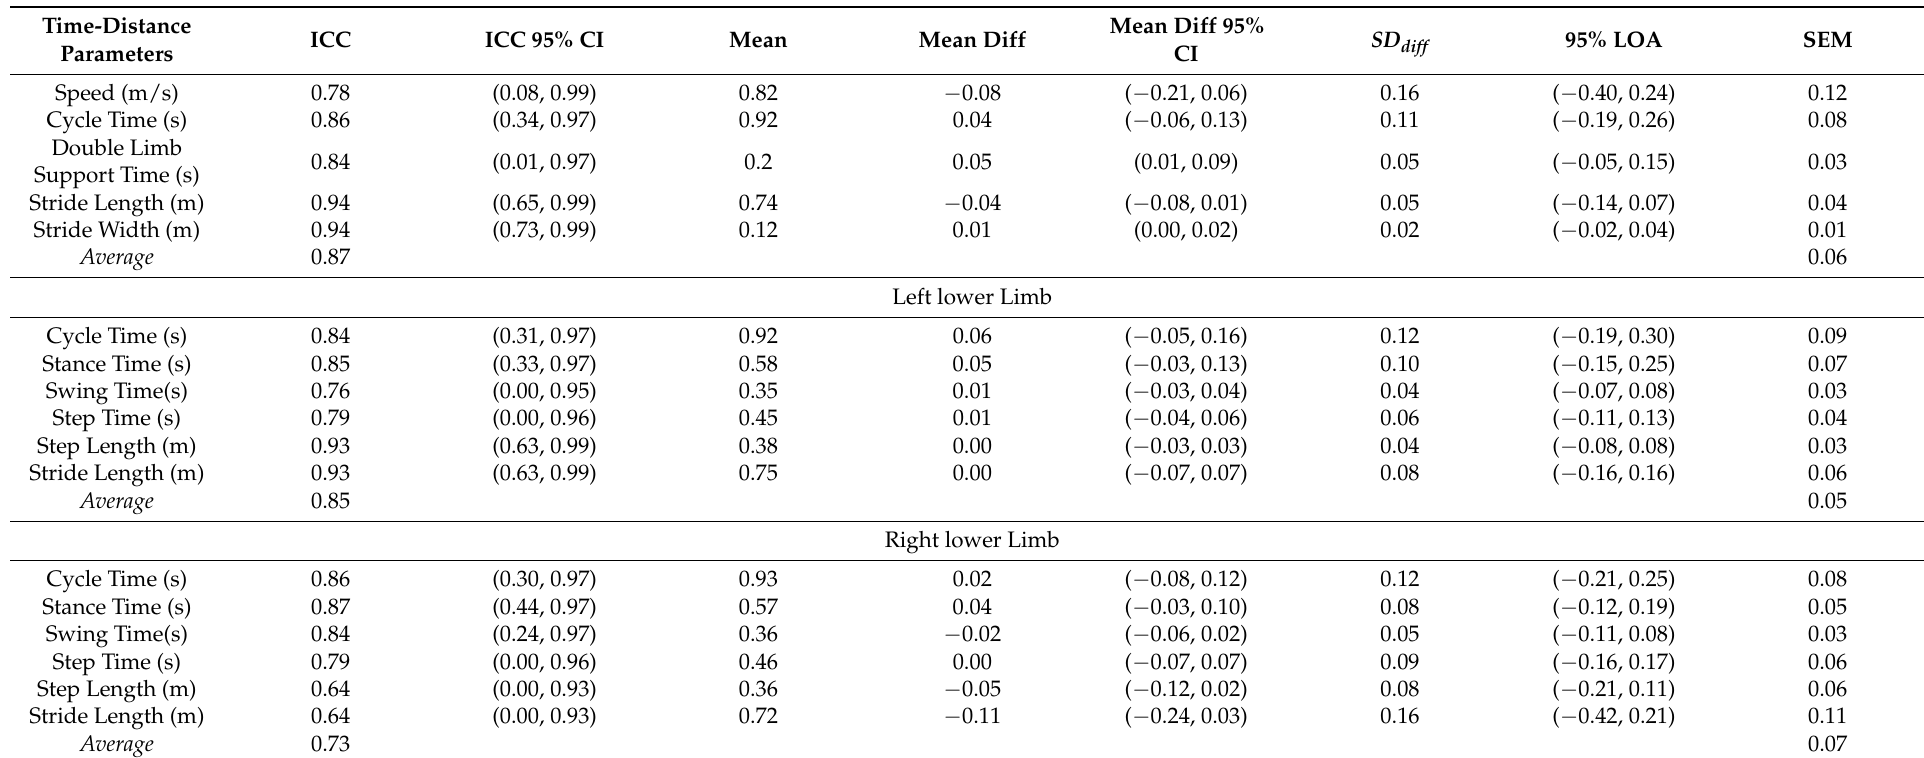
Table 3. Reliability values for time-distance